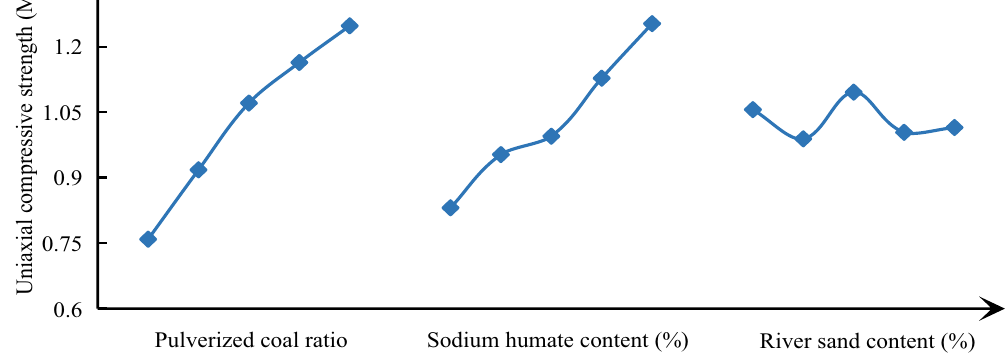
Figure 5. Effect curve of uniaxial compressive strength of similar materials.